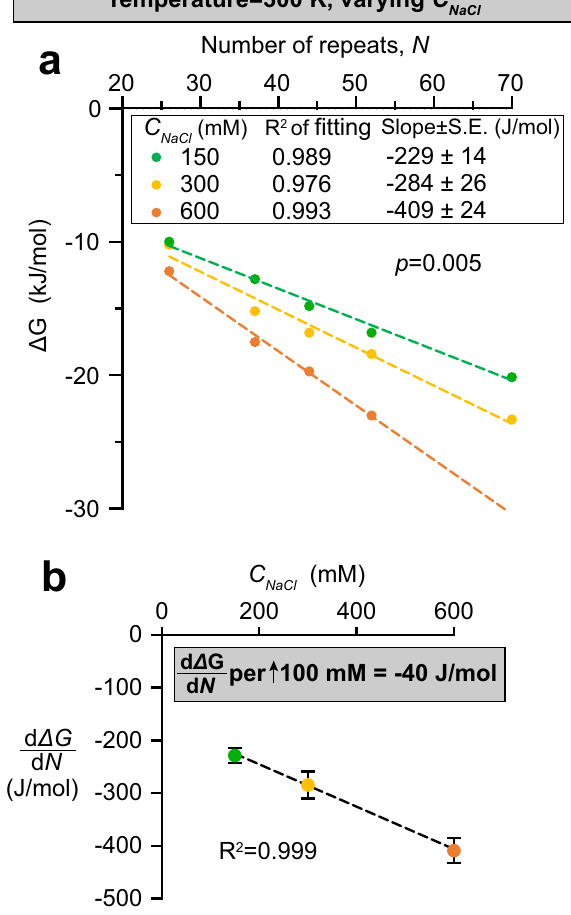
Fig. 7 | Gibbs free energy change per FG repeat unit scales linearly with salt concentration. a Datasets of saturation concentrations obtained at 150, 300 and 600mMNaCl(showninFig.5a,Supp.Fig.4aandSupp.Fig.4b,respectively)under thesametemperature(300K),areconvertedto Δ G against N byEq.2.Eachplotcan be fi ttedwithalinearfunctionwithahighR-squaredvalue. b Slopesof Δ G against N (i.e., d Δ G ) derived from ( a ) are plotted against NaCl concentration ( C NaCl ). Data are dN presented as mean values with S.E. of fi tting as error